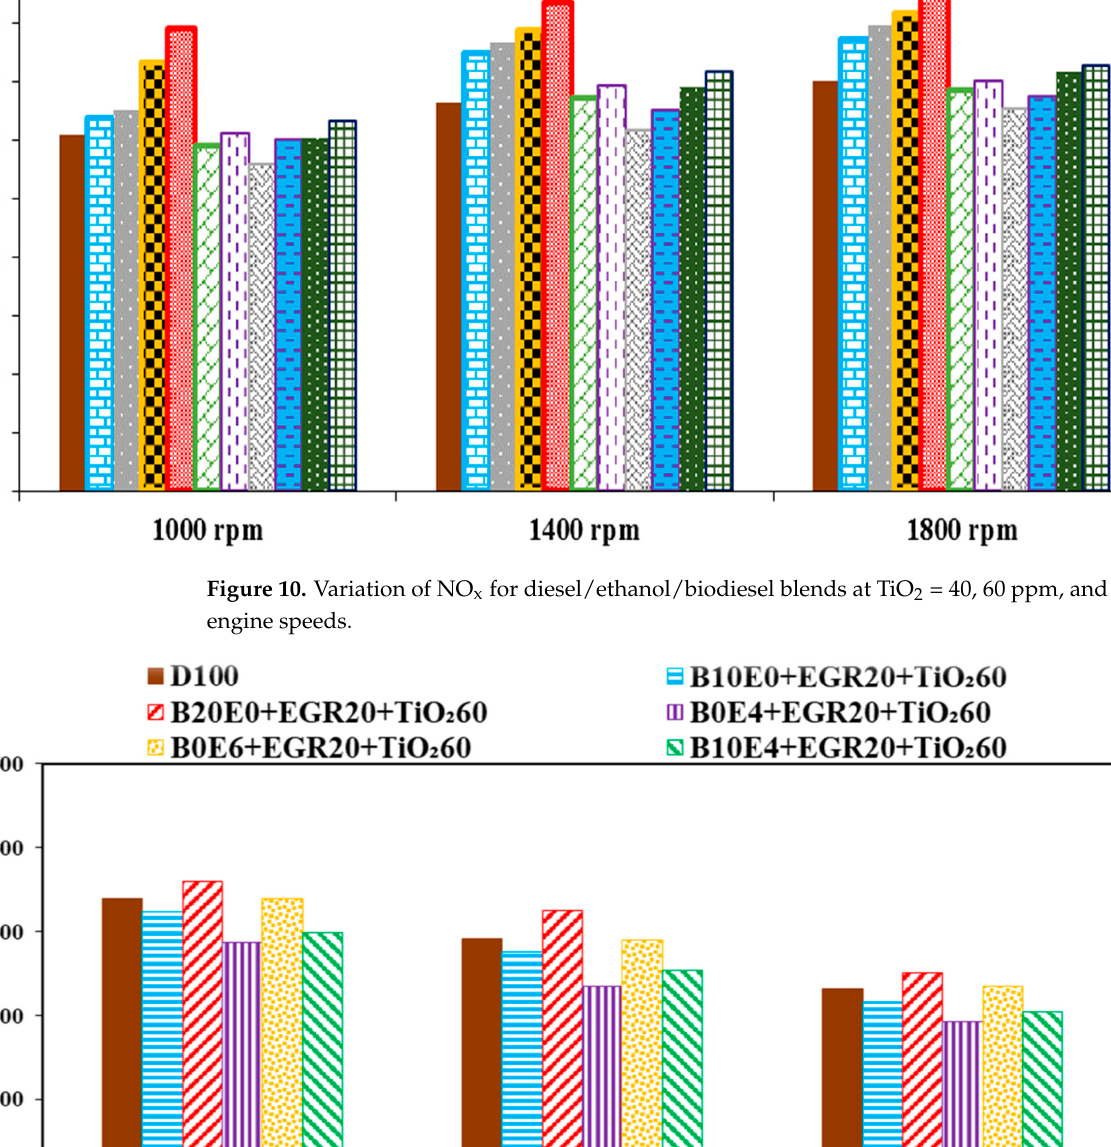
Figure 11. Variation of NO x for diesel/ethanol/biodiesel blends at EGR = 20%, TiO 2 = 60 ppm, and various engine speeds.